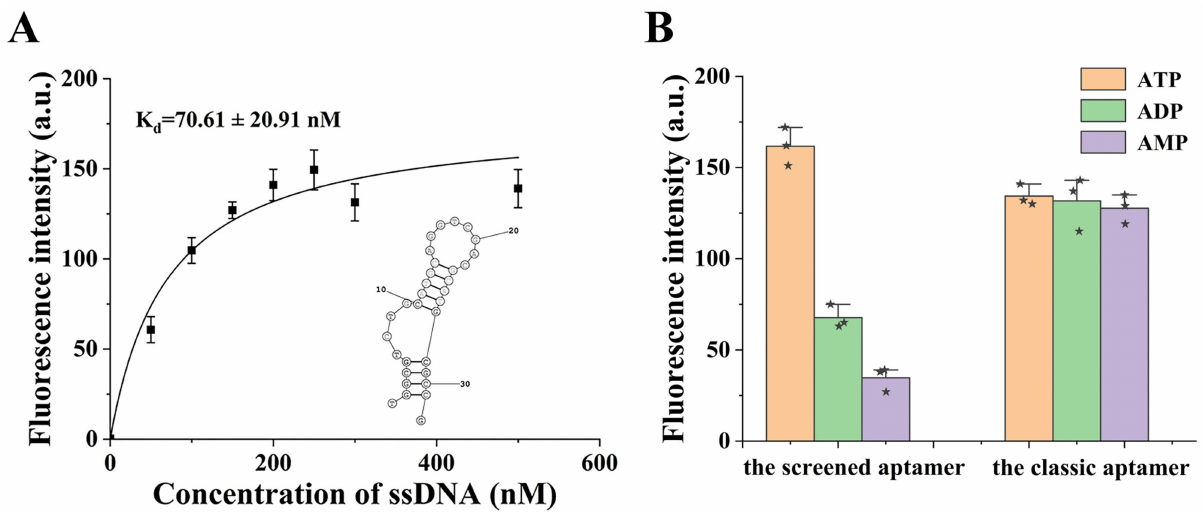
Figure 1. ( A ) The saturation curve and the dissociate constant (K d ) of the aptamer. Inset shows the secondary structure of the obtained aptamer. ( B ) Specificity of the screened aptamer and the classic adenosine triphosphate (ATP) aptamer. The Asterisk represents the individual data points (n = 3).